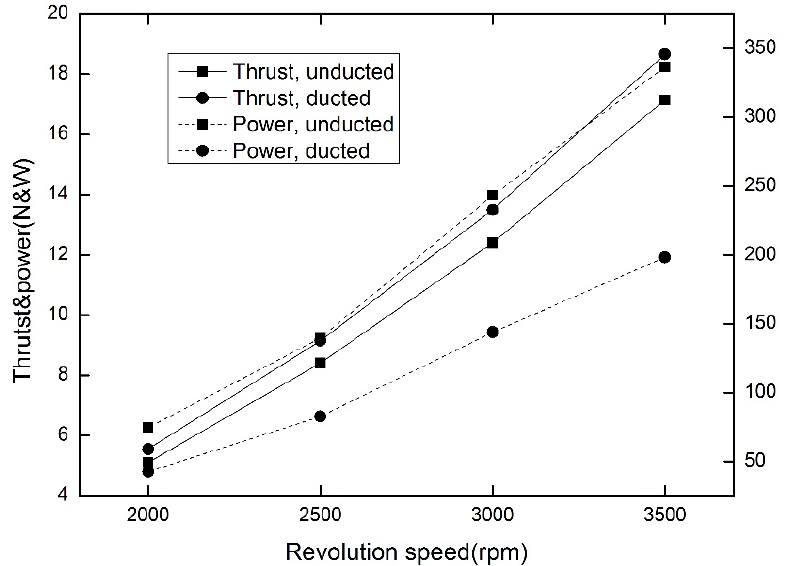
Figure 16. Thrust and power consumption of unducted propellers and ducted fan UAV.